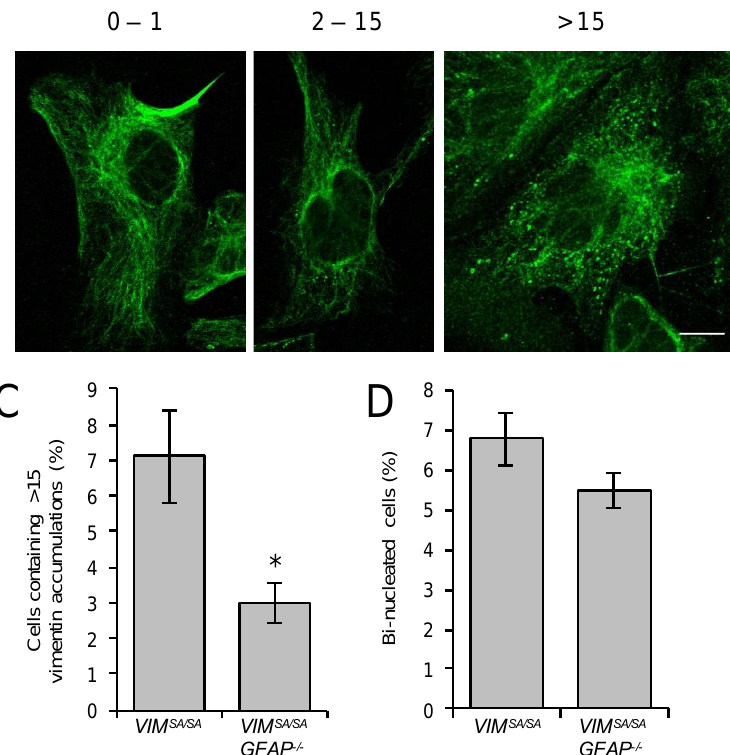
Figure 5. The fraction of immature VIM SA / SA astrocytes with abundant vimentin accumulations is reduced in the absence of GFAP. ( A ) Immature VIM WT / WT and VIM SA / SA astrocyte cultures were lysed and total protein levels of GFAP, vimentin, and nestin were compared by western blot analysis (normalized to GAPDH). Vimentin levels were lower in immature VIM SA / SA astrocytes. N = 4 per genotype; *** p < 0.001. ( B – D ) Immature VIM SA / SA and VIM SA / SA GFAP − / − astrocyte cultures were fixed, and vimentin was detected by immunofluorescence. ( B ) Examples of astrocytes with varying number of vimentin accumulations. ( C ) Astrocytes containing > 15 vimentin accumulations were less abundant in VIM SA / SA GFAP − / − compared to VIM SA / SA cultures. ( D ) The fraction of bi-nucleated cells was comparable between VIM SA / SA and VIM SA / SA GFAP − / − astrocytes. N = 6 per genotype; * p < 0.05. Scale bar 10 µm.